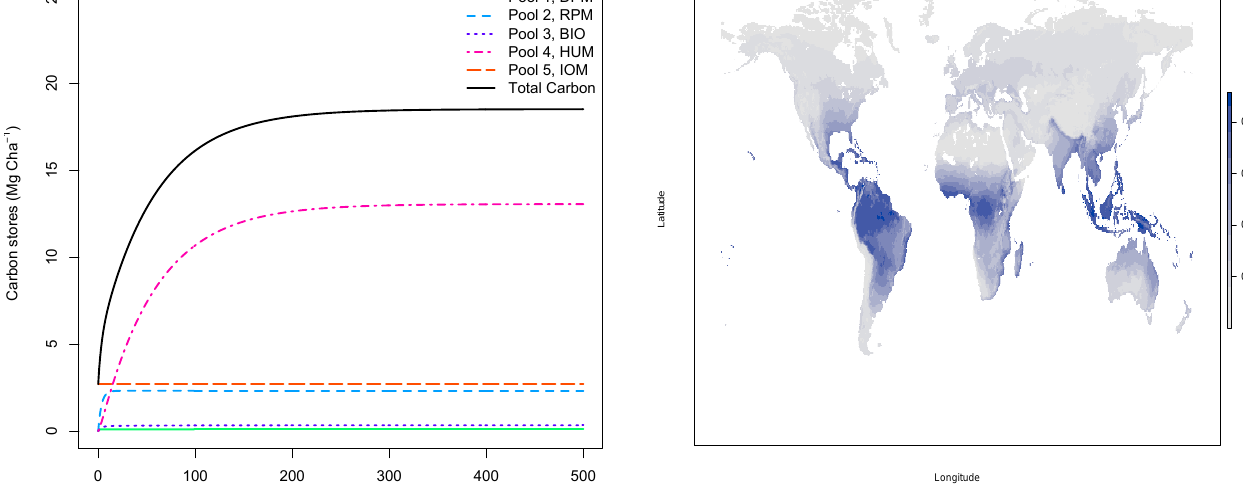
Fig. 5. Climate decomposition index (CDI) calculated as the prod- uct of a function of temperature ( fT.Century1 ) and a function of precipitation and potential evapotranspiration ( fW.Century ) us- ing monthly data from the WATCH dataset (Weedon et al.,